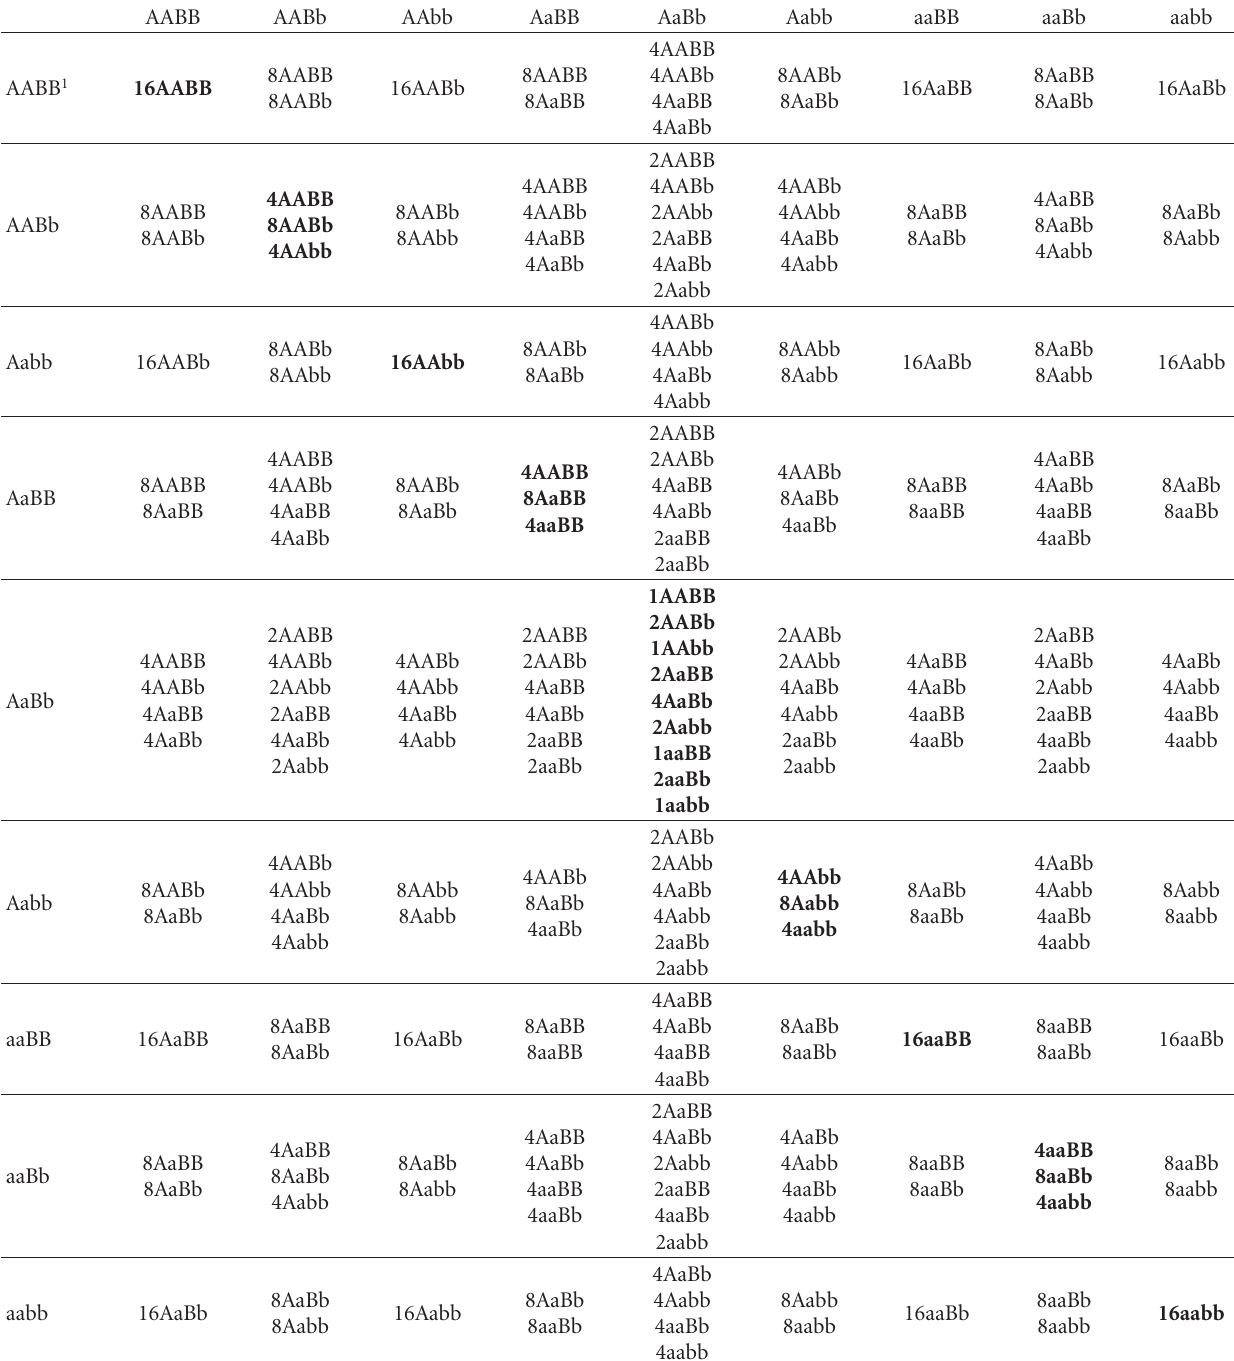
Table 1: Nine genotypes of each sex and the 81 possible crossings and their